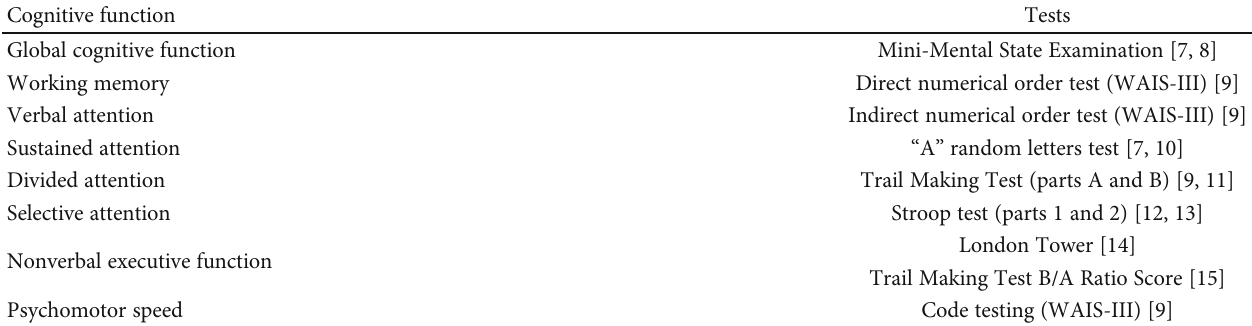
Table 1: Cognitive functions and corresponding tests